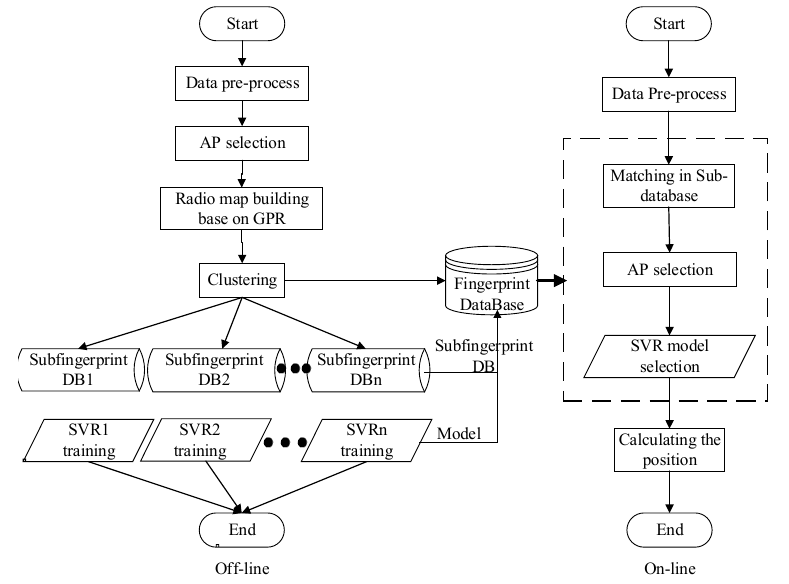
Figure 1. Overview of localization algorithm.